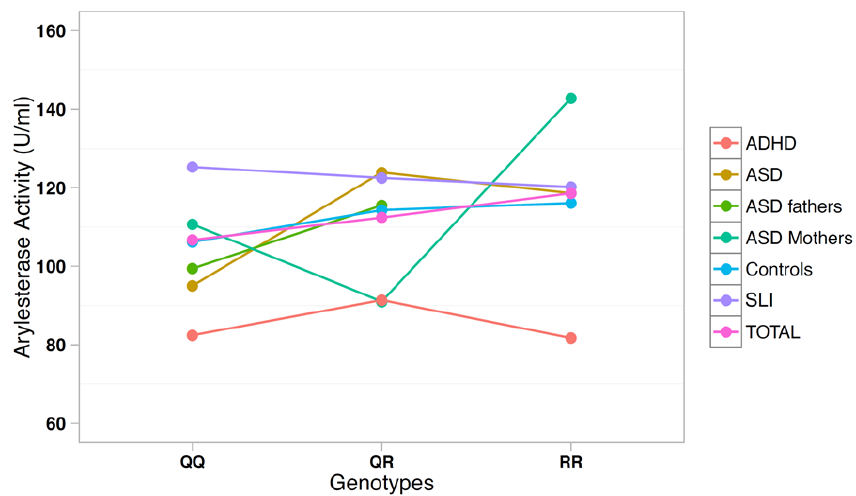
Figure 4. Arylesterase activity of the PON1 genotype at SNP rs662 (Q192R).